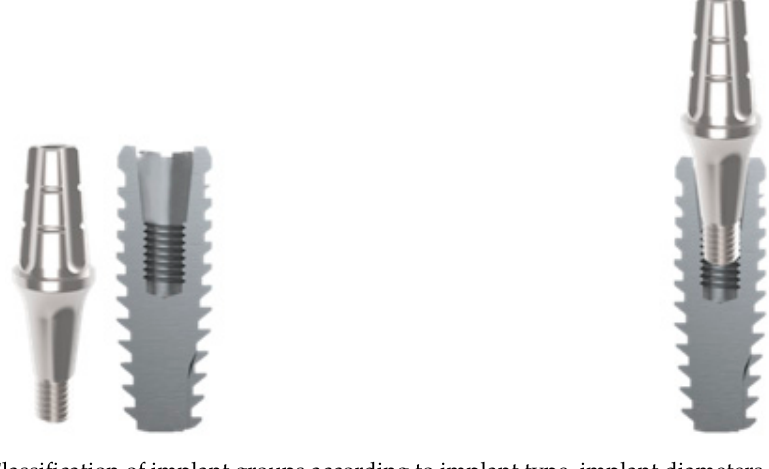
Figure 1. Classification of implant groups according to implant type, implant diameters and lengths, and the region of the prosthetic abutment before the mechanical test.